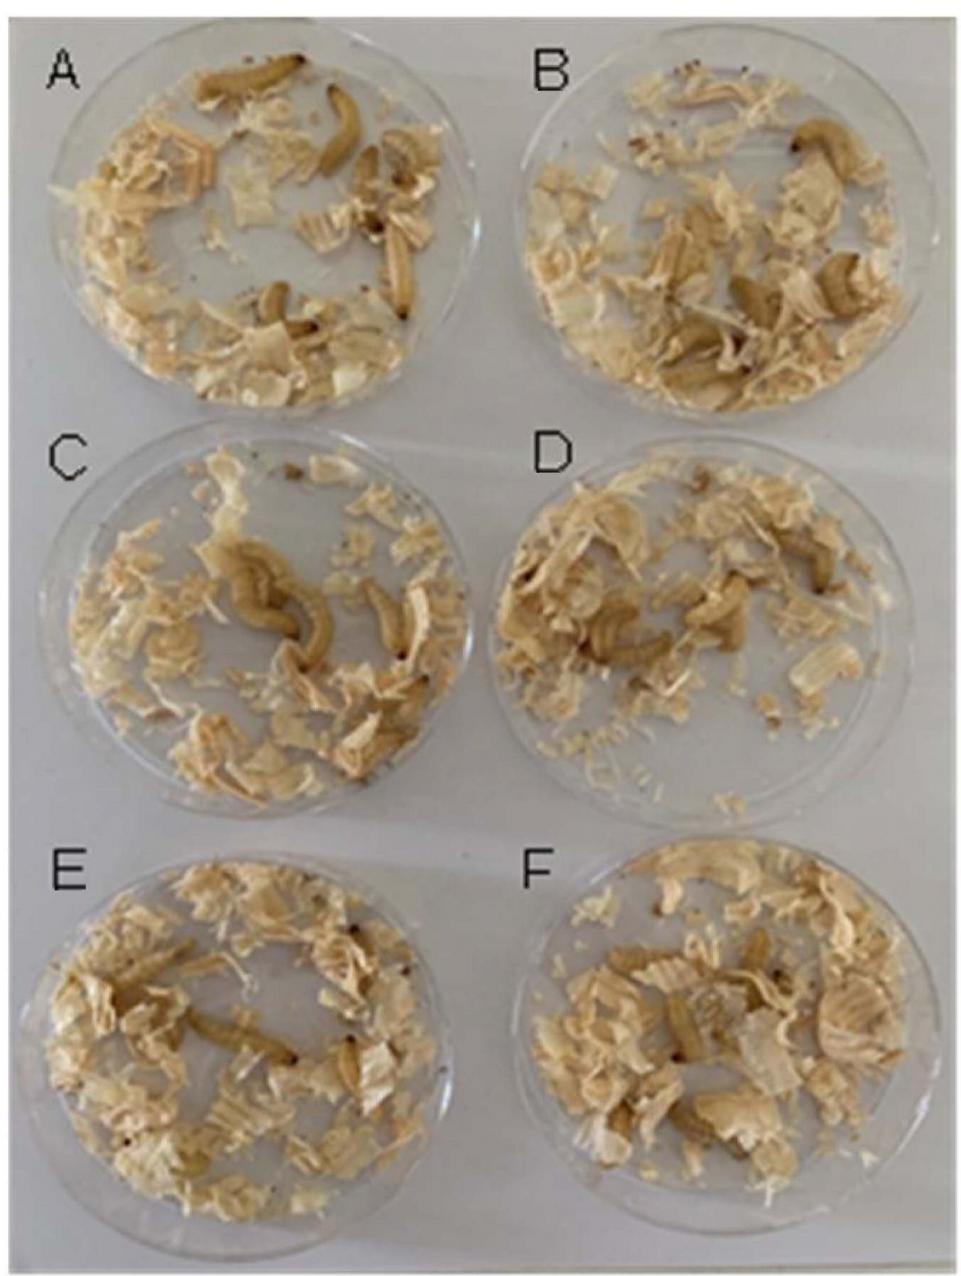
Figure 5. Survival of G. mellonella larvae treated a range of PS9 concentrations after 24 h. ( A ) Untreated larvae and larvae treated with PS9 , ( B ) 100 µ g/mL, ( C ) 250 µ g/mL, ( D ) 500 µ g/mL, ( E ) 750 µ g/mL and ( F ) 1000 µ g/mL, ( n =